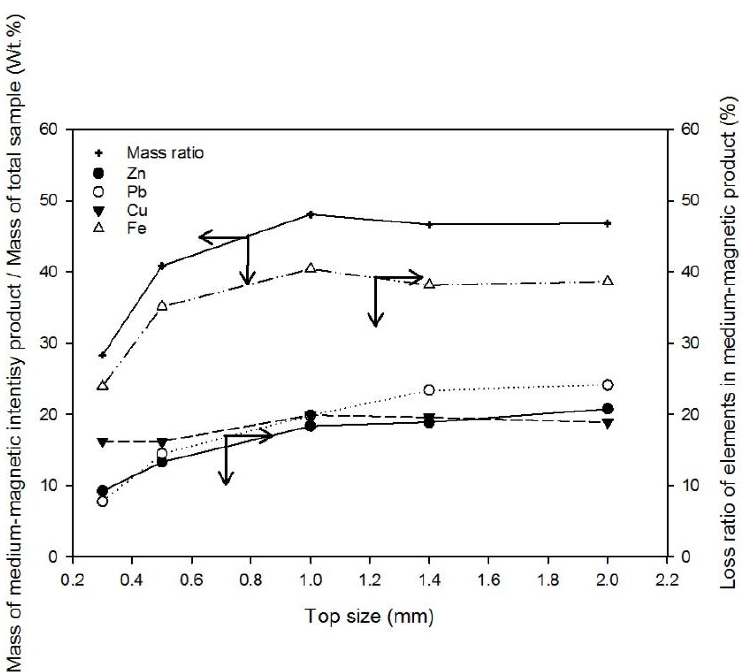
Figure 7. Mass fraction (wt %) of products extracted at medium magnetic intensity (0.6 T non-magnetic/0.85 T magnetic products) and loss ratio of target elements as functions of maximum size of feed-sample particles.